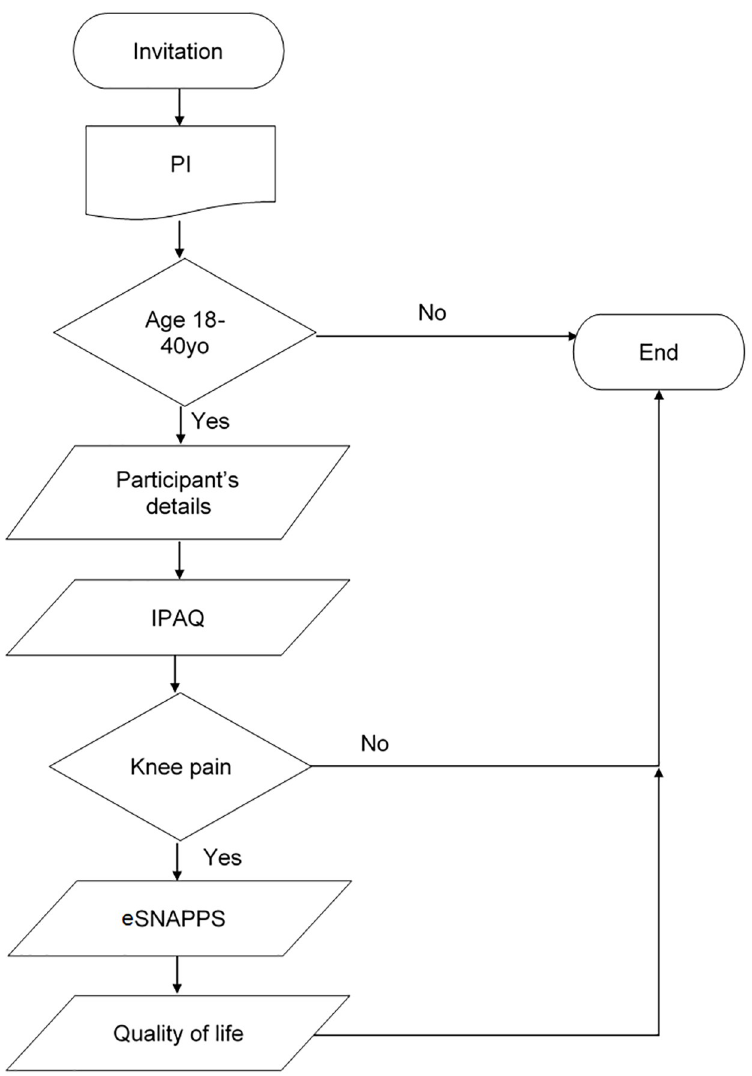
Fig 1. Data collection flow chart. Showing the process for data collection. Acronyms included in the figure: Participant information (PI); International Physical Activity Questionnaire (IPAQ); eSurvey instrument for Natural history, Aetiology and Prevalence of Patellofemoral pain Studies